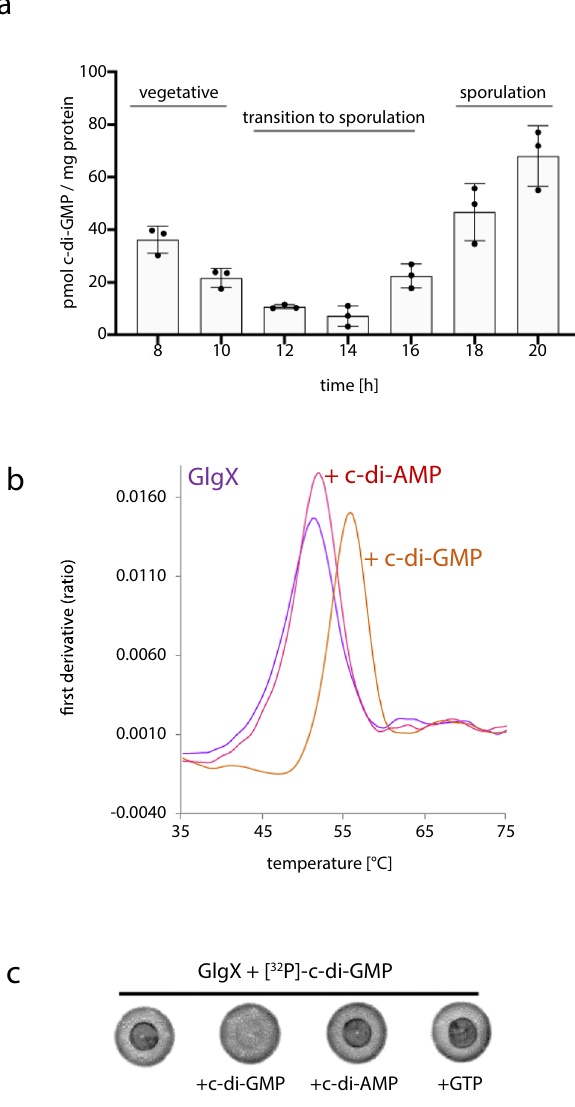
Fig. 1 | GlgX binds c-di-GMP. a Quanti fi cation of c-di-GMP in S. venezuelae cell extracts using LC-MS/MS. Cells were harvested during late vegetative growth (8 – 10h), transition to sporulation (12 – 16h), and sporulation (18 – 20h). Data are presentedasthemeanofbiologicalreplicates±SD( n =3).Sourcedataareprovided intheSourcedata fi le. b nanoDSFthermalshift fi rst-derivativecurvesof10 µ MGlgX withoutanyligand(purple),with1mMc-di-AMP(pink),or1mMc-di-GMP(orange). c-di-GMP increases the melting point of GlgX from 51.5 to 55.8°C. Source data are provided in the Source data fi le. c [ 32 P]-c-di-GMP binds to GlgX in DRaCALA assay indicated by dark spots in the center of the nitrocellulose membrane. For com- petition,excess(100 µ M)ofunlabeledc-di-GMP,c-di-AMP,orGTPwasaddedtothe reaction containing [ 32 P]-c-di-GMP and